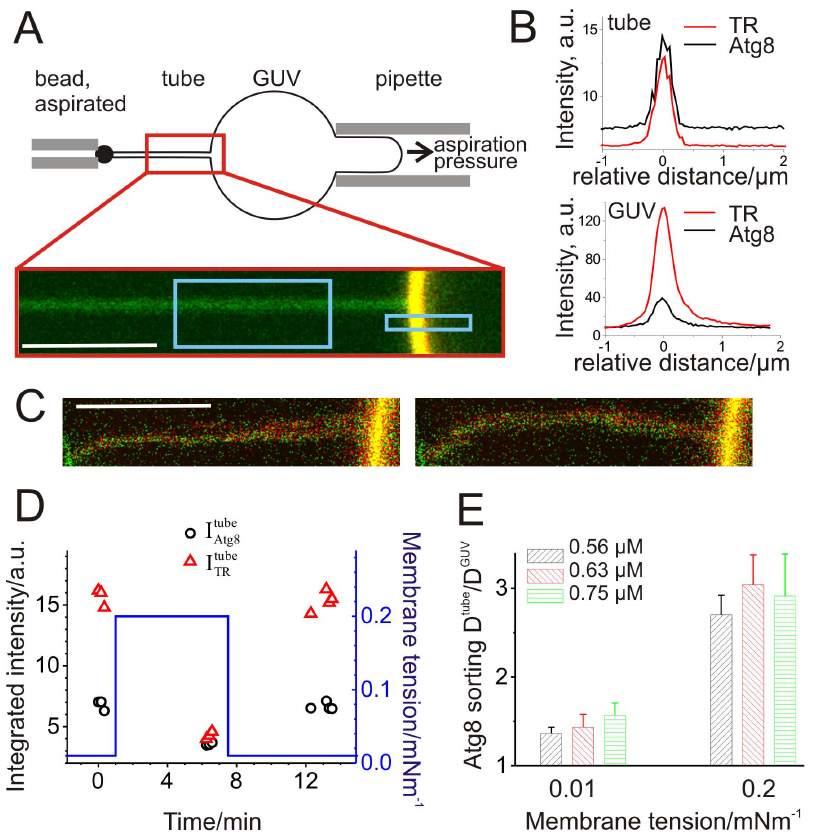
Fig. 3. Atg8-PE stabilizes membrane curvature and sorts into strongly curved membanes. ( A ) Setup used for tube pulling. After aspiration, the vesicle containing biotinolyted lipids and the streptavidin coated bead were brought in contact and adhere. Once bound, a tube was pulled by moving the pipette holding the bead, a confocal xy-scan illustrates such a membrane tube pulled from a GUV. ( B ) Fluorescence intensity profiles of the membrane tube (top) and the corresponding GUV membrane (bottom) of the boxed regions in ( A ). ( C ) At high Atg8-PE densities, pulled tubes appeared blurry and exhibit pronounced fluctuations. Two consecutive xy-scans of the same tube illustrate movements of the tube; see also S1 Video. ( D ) Increasing the membrane tension of the GUV at time t 5 1 min (blue line, right axis) decreases the radius of the membrane tube from 70 nm to 16 nm and accordingly changes the intensities of the membrane tube and Atg8-PE (data points, left axis). This change is reversible as shown with decreasing the tension at time t 5 7 min. For experimental details see methods. Data points correspond to consecutive scans of one individual tube. ( E ) The normalized Atg8-PE densities in the tube D tube /D GUV increase with tension. Three different Atg8 concentrations are shown, n 5 7 GUVs for 0.56 and 0.63 m M Atg8, n 5 3 GUVs for 0.75 m M Atg8, mean ¡ sem. The scale bars in ( A ) and ( C ) are 5 m